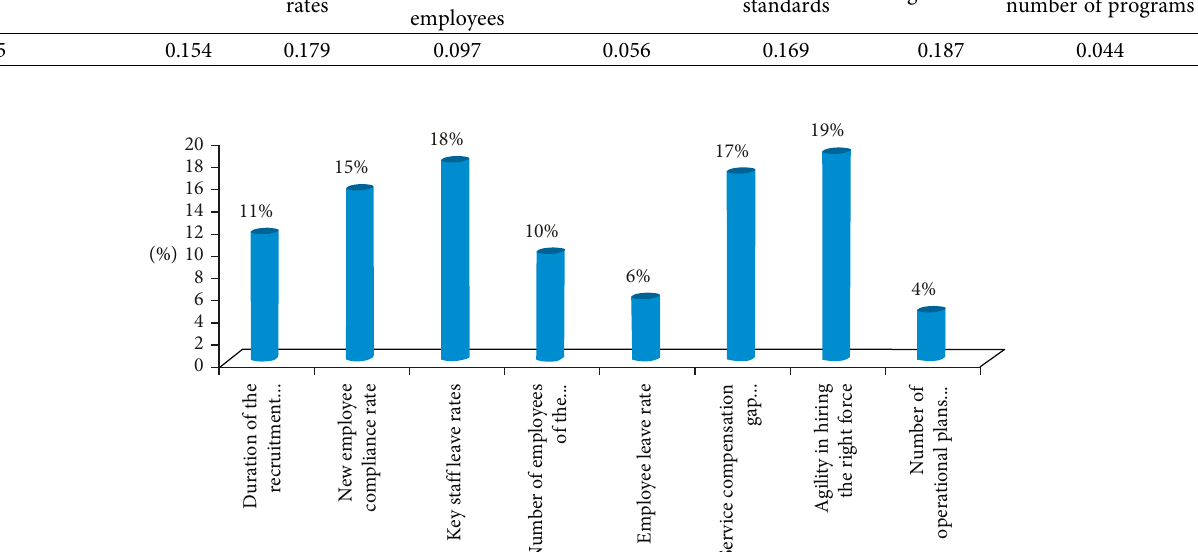
Figure 4: Weight of criteria in terms of internal